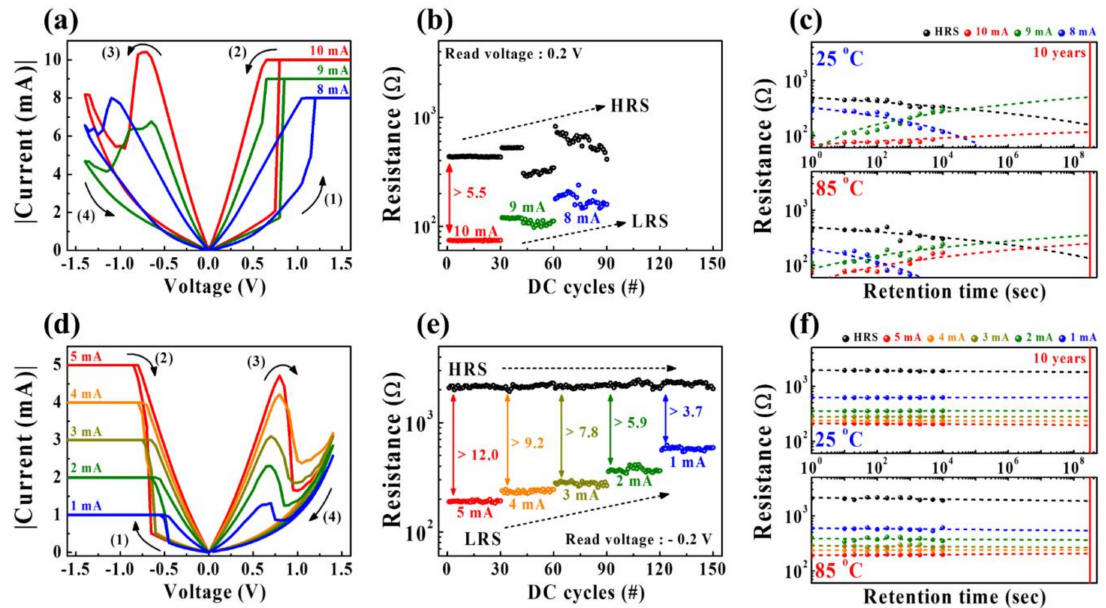
Figure 7. Multilevel RS characteristics through I cc modulation for HSQ memristors w/o ( a – c ) and w/ ( d – f ) the embedded SWCNT random network. ( a,d ) Multilevel BRS I – V curves. ( b,e ) Multiple-resistance state endurance characteristics. ( c,f ) Nonvolatile multiple-resistance state retention characteristics for 10 4 s at room temperature (25 ◦ C) and high temperature (85 ◦